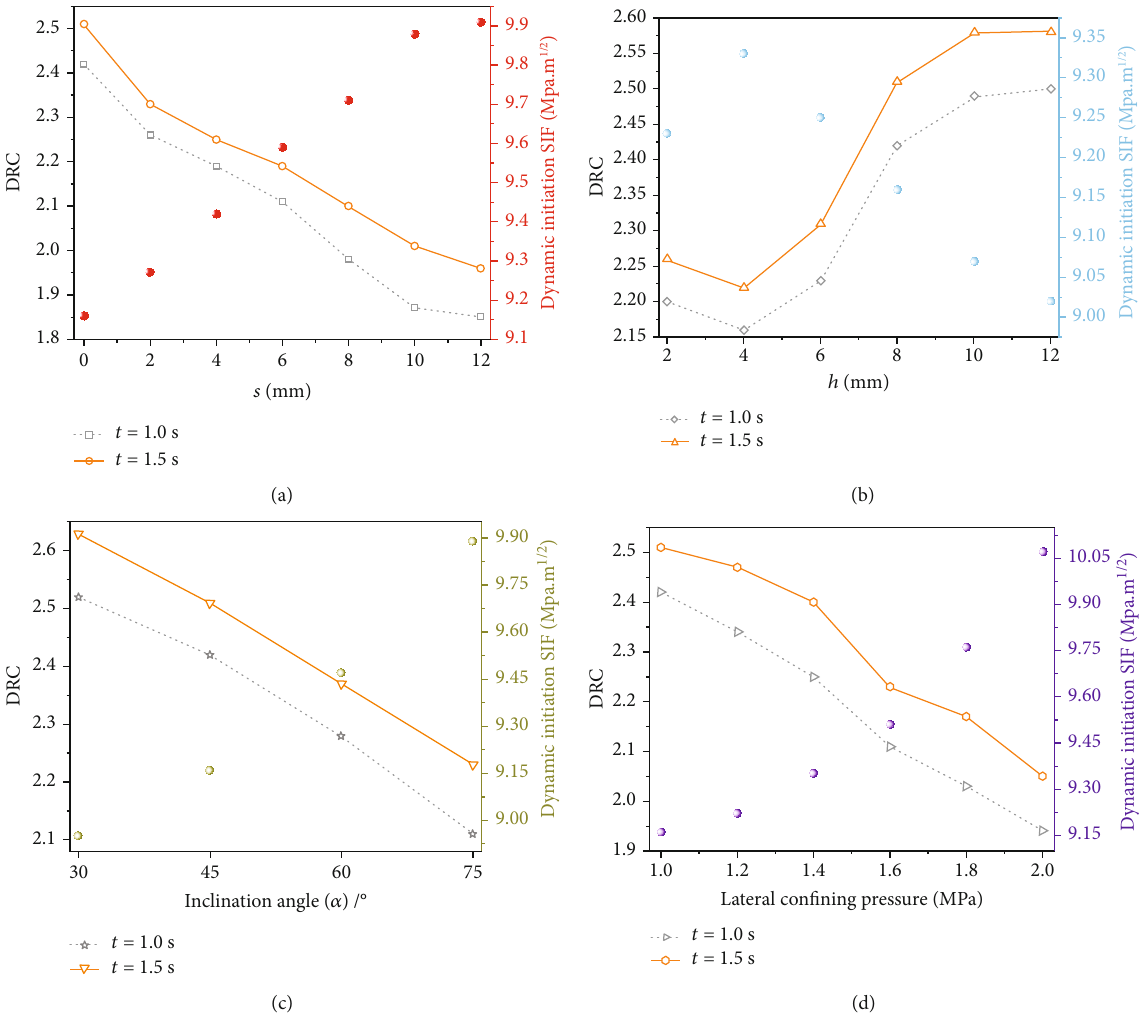
Figure 18: DRC and dynamic initiation SIF variations in crack tip as per various factors. (a) Variations with length of rock bridge ( s ). (b) Variations with staggered distance ( h ). (c) Variations with crack inclination angle ( α ). (d) Variations with lateral con fi ning